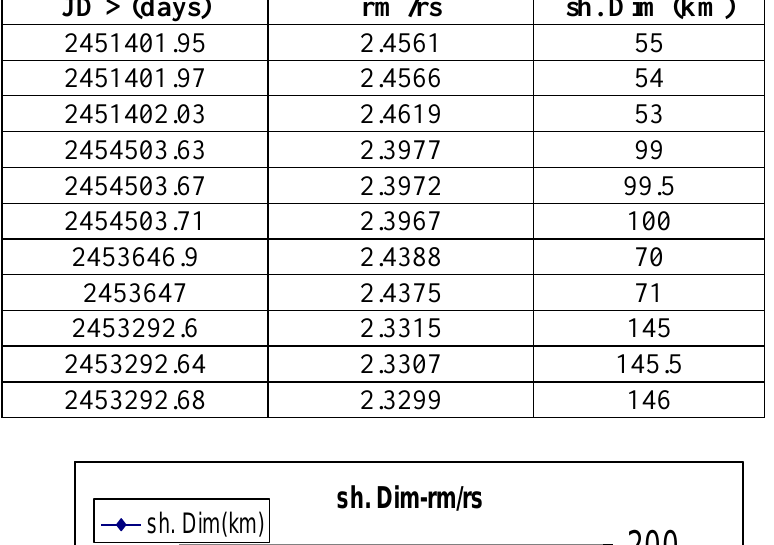
Table 13: Shadow area variation with rm/rs